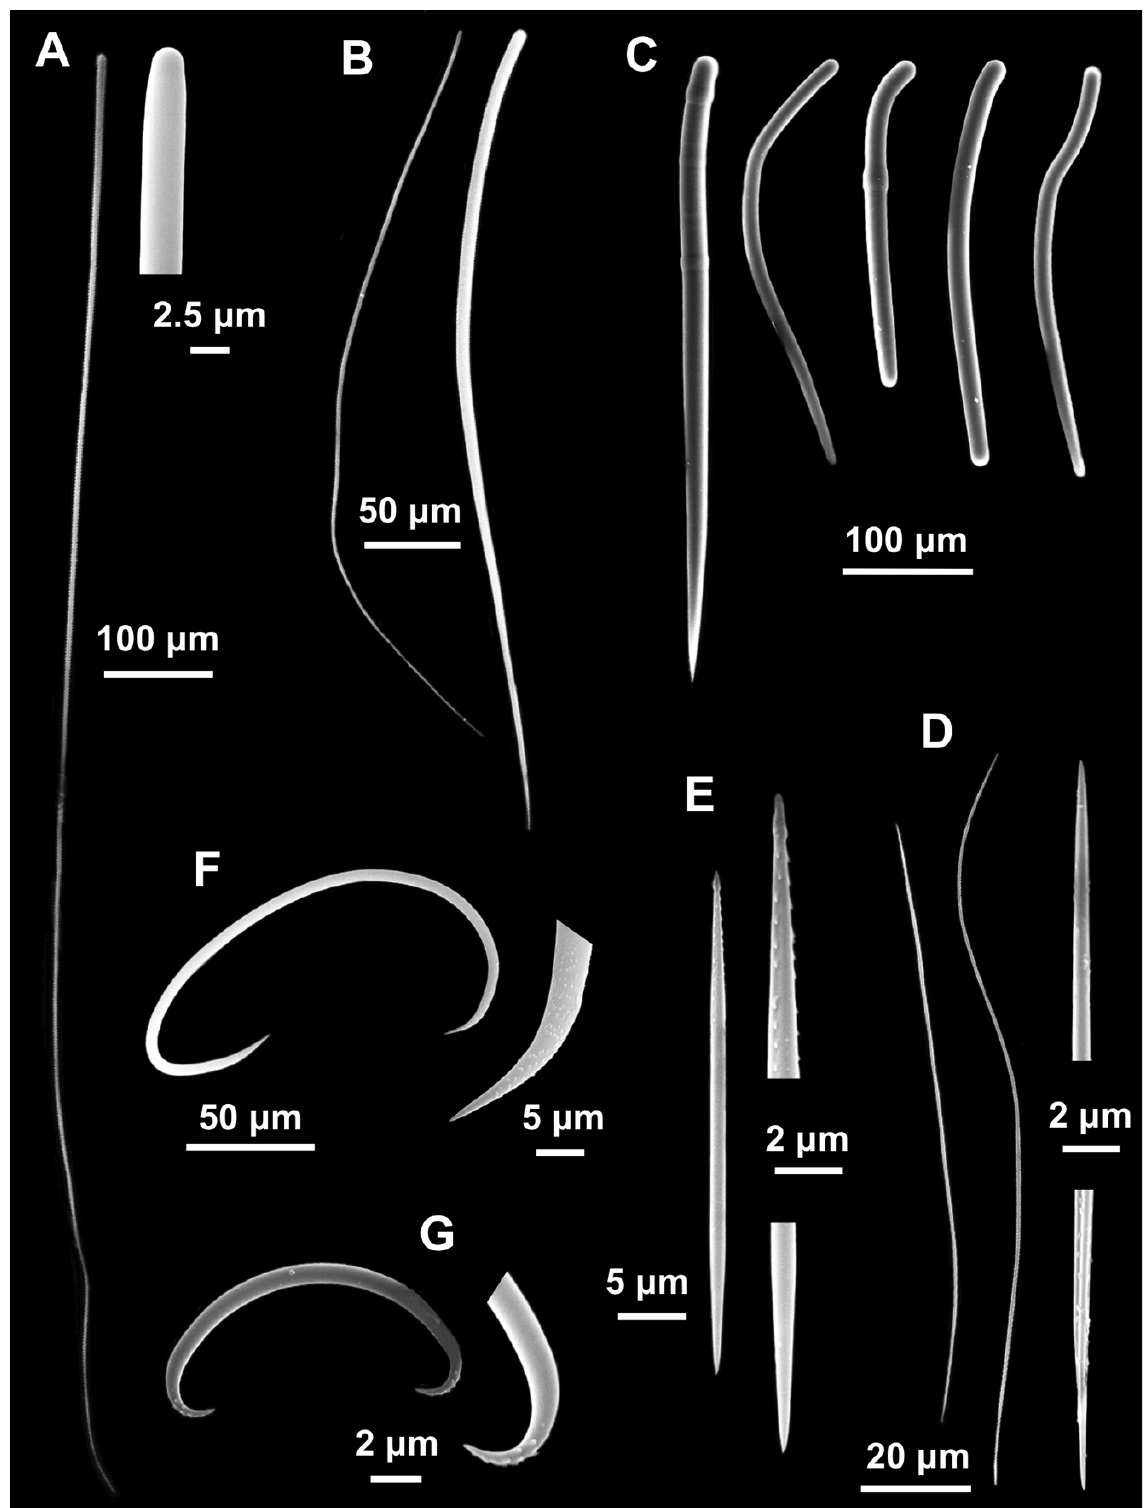
Fig. 12. Spicules of Biemna typica Bertolino, Costa & Pansini sp. nov., holotype (CILE 28; MSGN 61495). A . Styles I. B . Styles II. C . Styles III, sometimes modified to rhabdostyles. D . Raphids I. E . Raphids II. F . Sigmas I. G . Sigmas